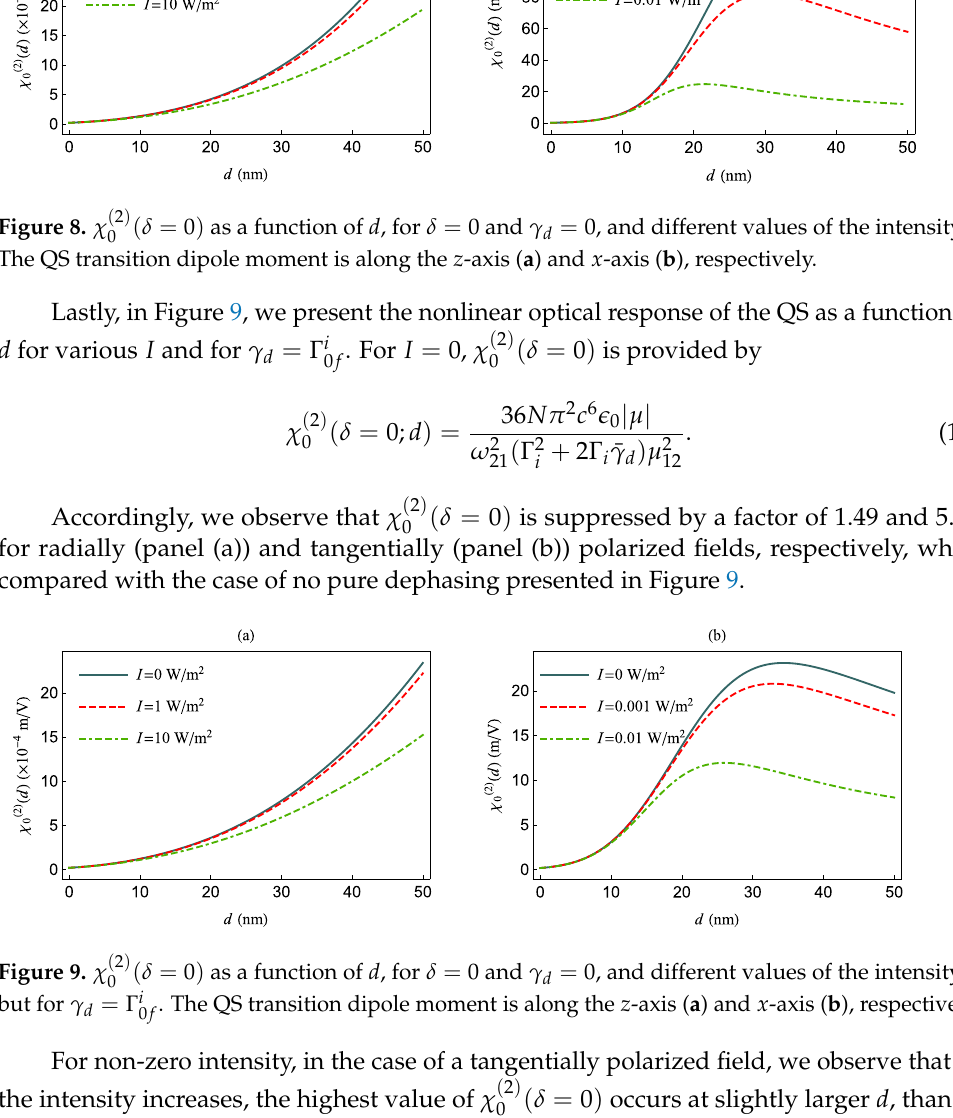
= 0, and different values of the intensity I , d